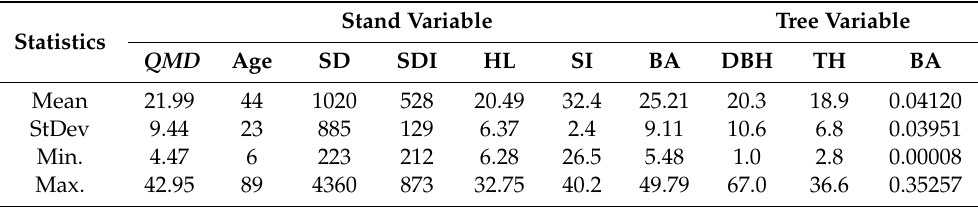
Table 1. Descriptive statistics for stand and tree